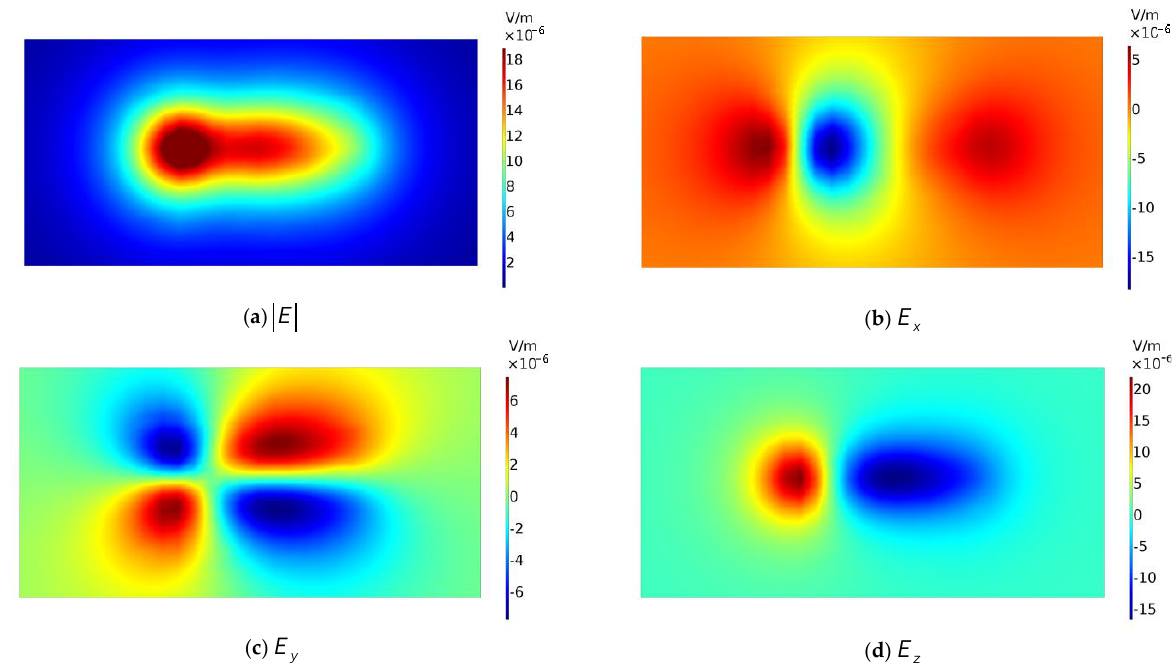
Figure 7. Electric field modulus and XYZ component distribution at 2B below the ship.